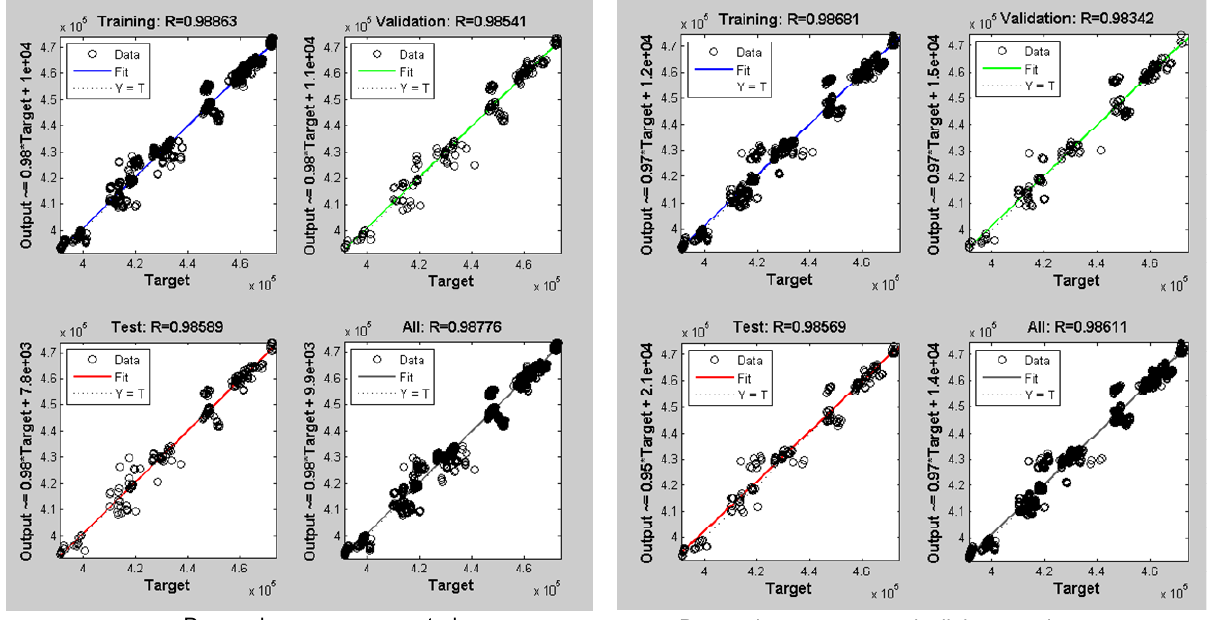
Figure 12. Neural network training and testing results for lighting electric